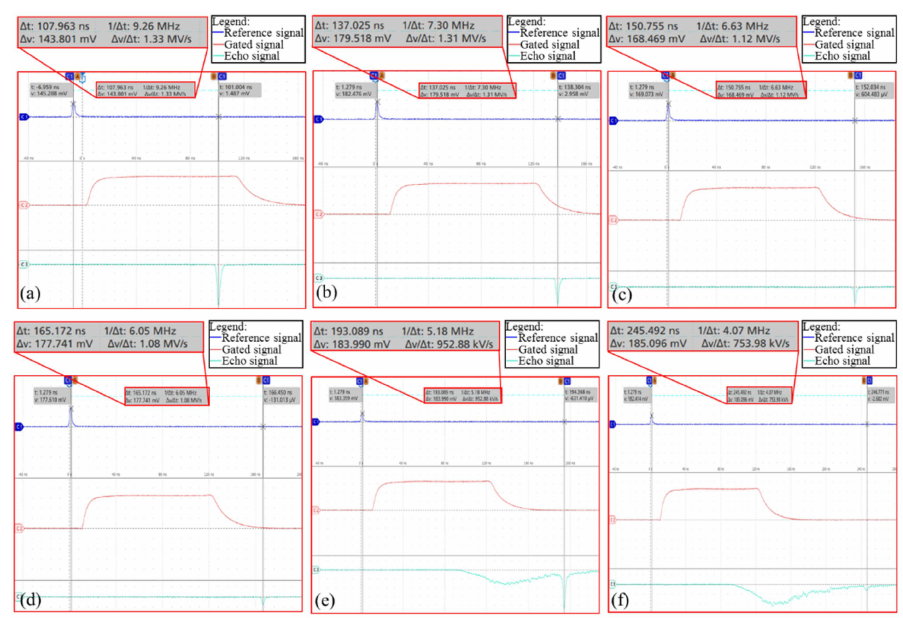
Figure 23. ( a – f ) Waveform diagram of the water pool